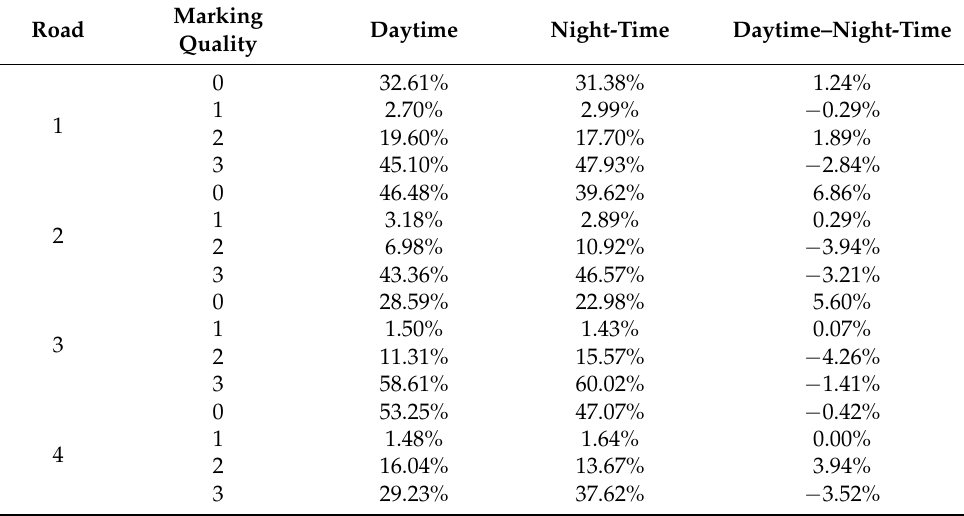
Table 3. Frequencies and percentages of samples by each marking quality rank for middle and edge lines during